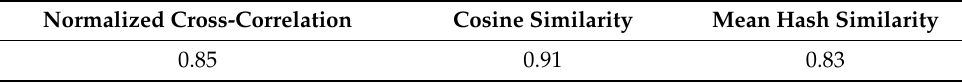
Table 3. Image similarity between the simulated image and the real SAR